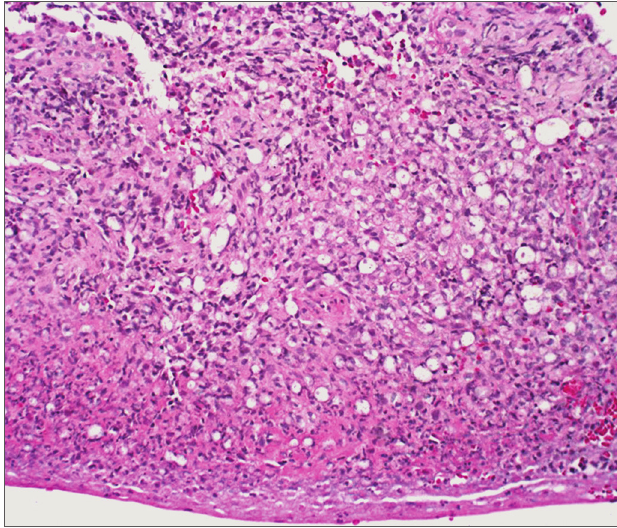
Figura 6. Rinite hansênica Lâmina com aumento 200x e coloração de Hematoxilina Eosina - Infiltrado inflamatório denso (células com núcleo roxo) e muitos macrófagos vacuolados.